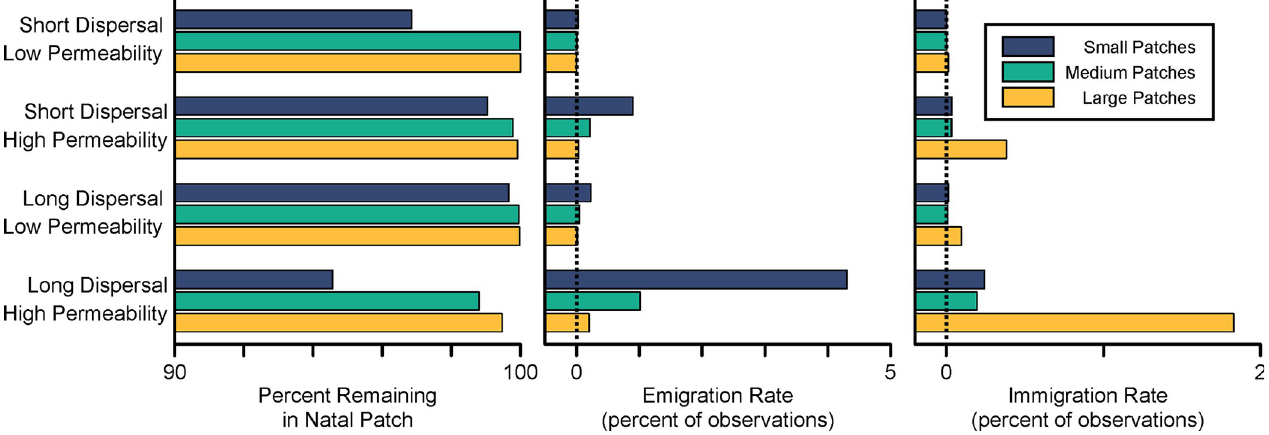
Fig 2. Observed migration rates of long or short-dispersing individuals across barriers of varying permeability during the Semi-Connected epoch. Left: Percent of the population that is born and reproduces in the same patch. Middle: Emigration rates, sorted by size of sending patch. Right: Immigration rates, sorted by size of receiving